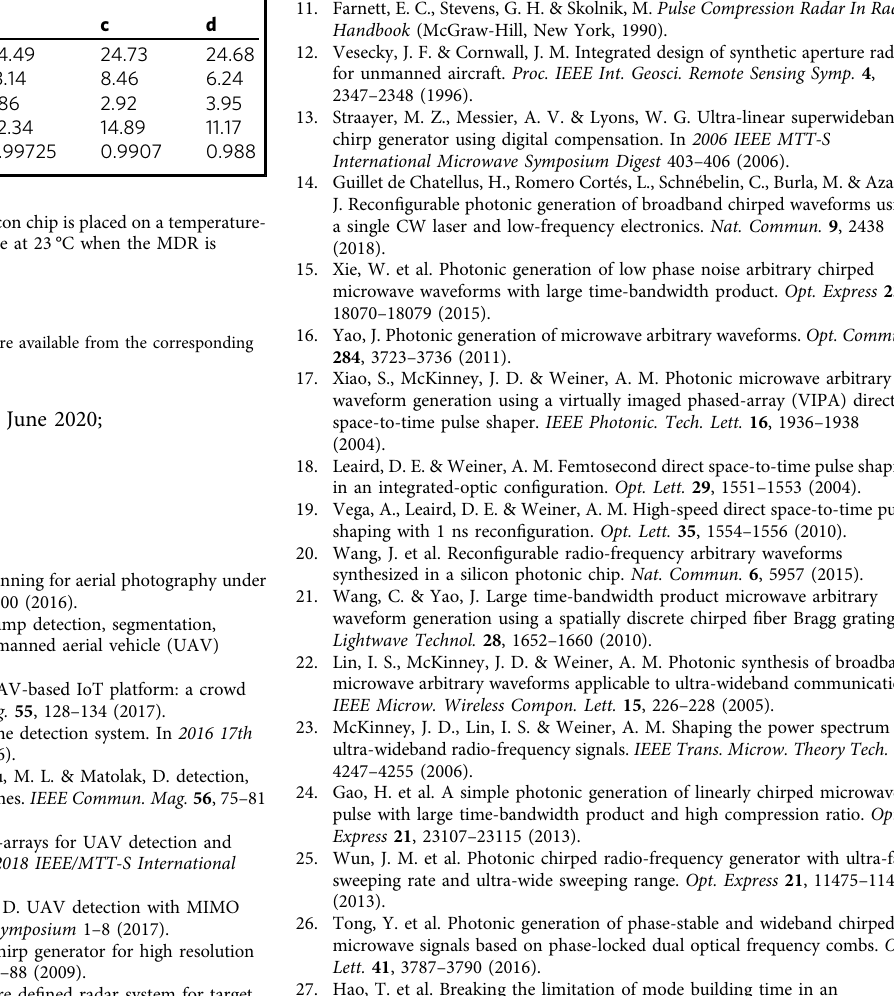
Table 3 Summary of the parameters of the LCMW in Fig.